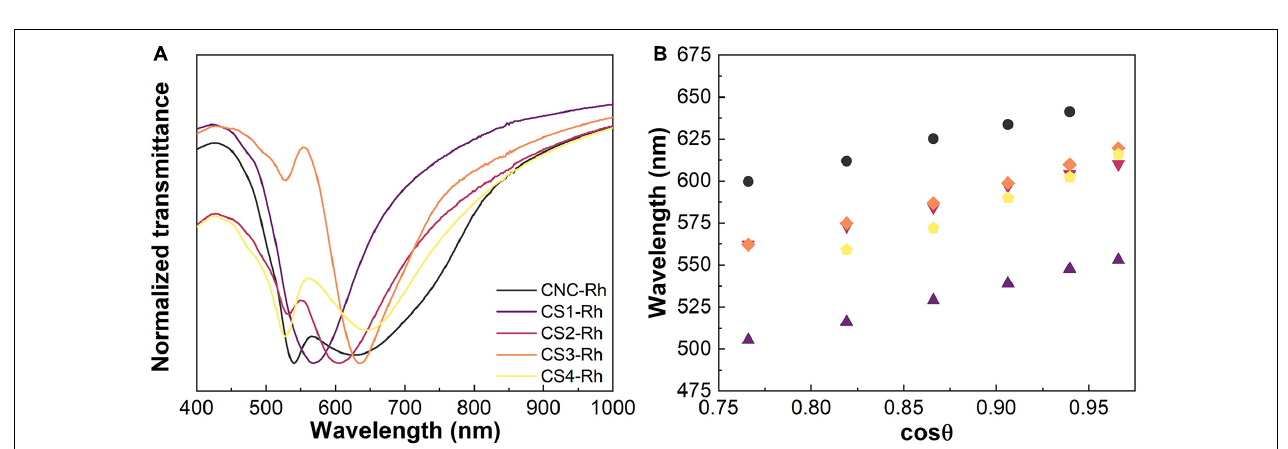
FIGURE 3 | Transmittance spectra of CNC, CS1, CS2, CS3, and CS4 samples (A) . Variation of the peak position of the reflectance spectra as a function of the cos θ for the same CNC/silica composites (B) .